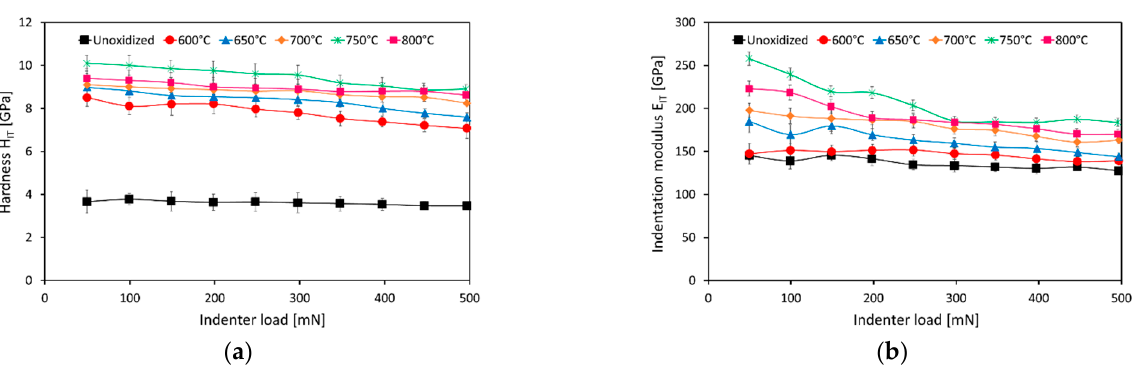
Figure 3. Hardness H IT ( a ) and indentation modulus E IT ( b ) of the Ti-6Al-7Nb alloy, depending on the oxidation temperature and indenter load.